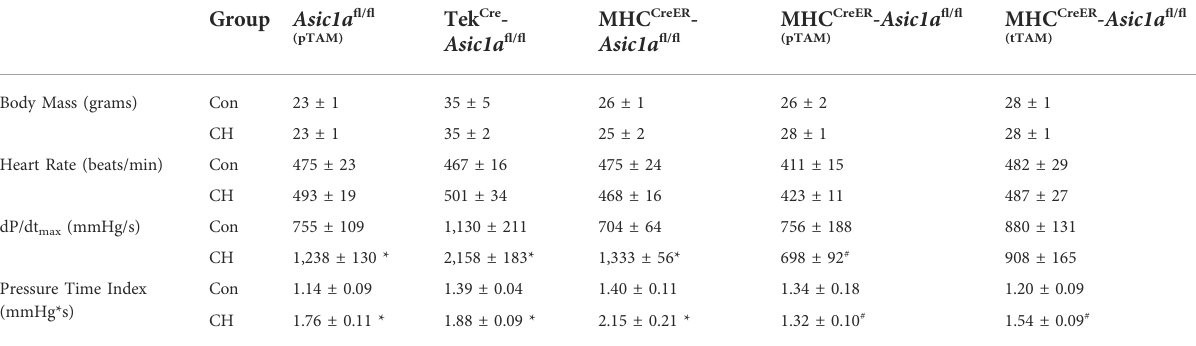
TABLE 4 Bodymass,heart rate,cardiac contractility, andpressure-time index inanesthetized controland CHgenetically-modi fi ed micetreated with or without tamoxifen (TAM). Group Asic1a fl / fl